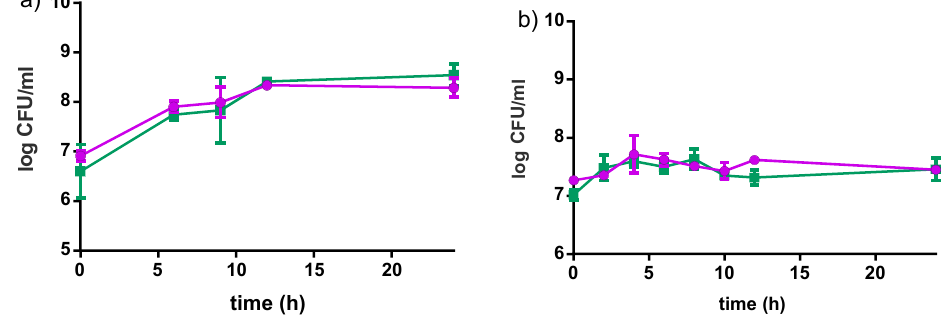
Figure 4. Growth curves of L. rhamnosus GR-1 ( ● ) and S. thermophilus C106 ( ■ ) as a consortium in the Fiti sachet ( a ), or as single cultures ( b ) in 8% pre-treated millet in water dispersion (60 min pre-treatment at 90–95 °C). Fermentation was carried out at 40 °C for 24 h. Mean values and error bars are based on two independent replicates. Table 2 . Viable counts (cfu/mL) of L. rhamnosus GR-1 (L. GR-1) and S. thermophilus C106 (S. therm.) in